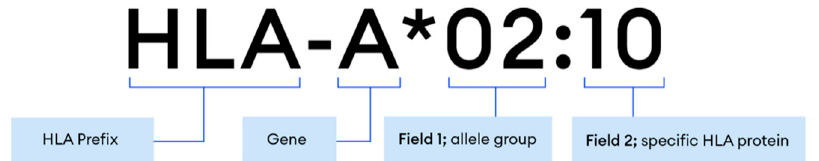
Figure 3. Proper nomenclature for HLA typing results.